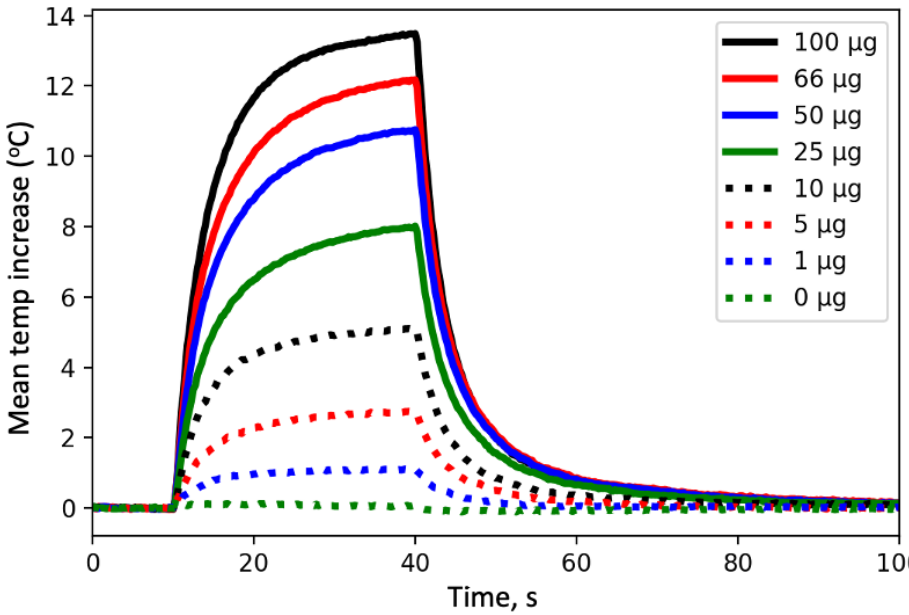
Figure 2. Eight measured temperature profiles for calibration filters. The calibration filters had between 0 and 100 micrograms of fullerene soot.